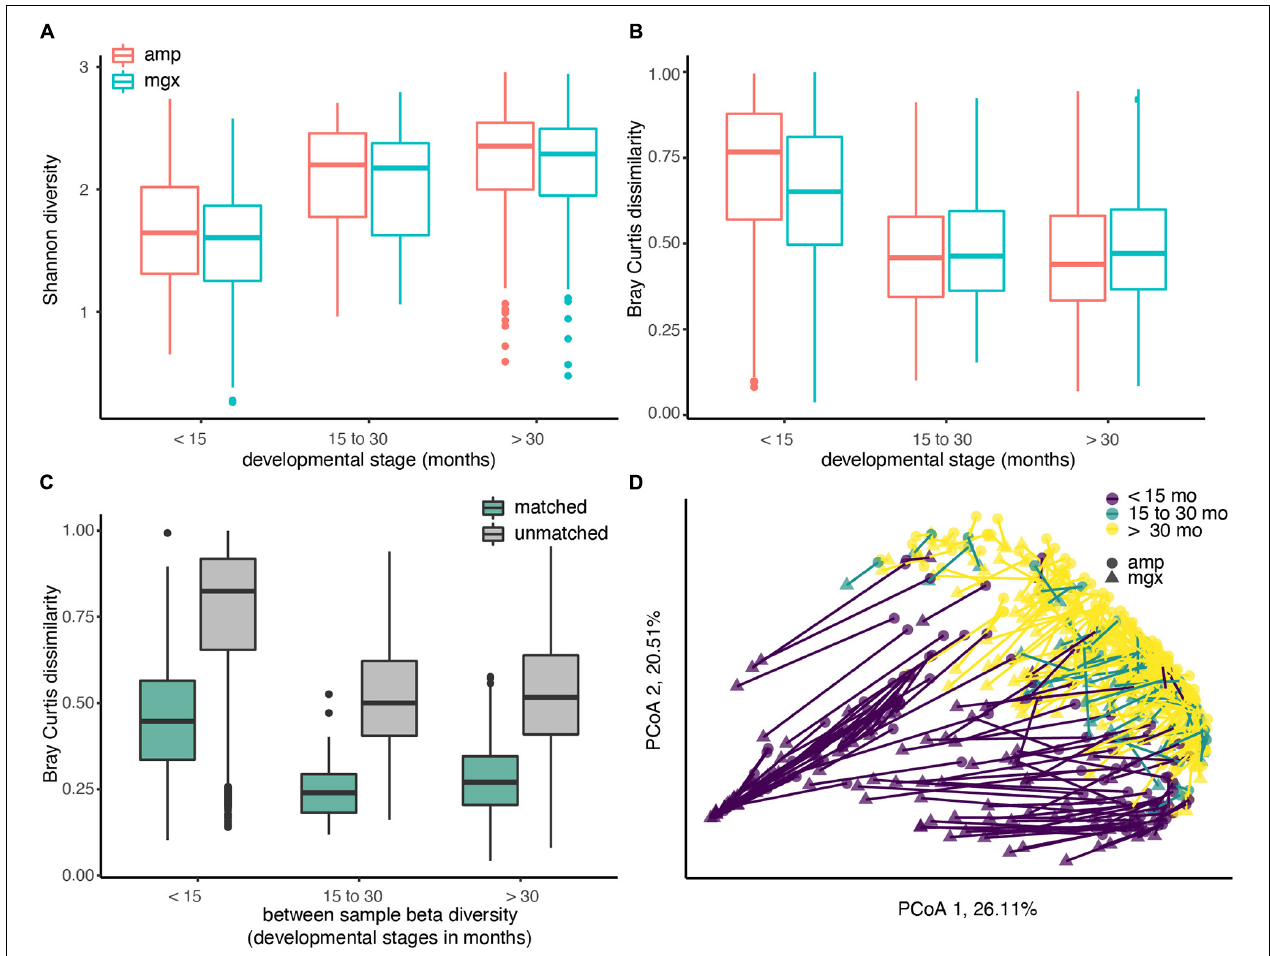
FIGURE 1 | Diversity of the child gut microbiome differs by age, regardless of profiling method. Microbiome communities from 338 children were sequenced using 16S rRNA (abbreviated “amp”) and shotgun metagenomic (abbreviated “mgx”) profiling. (A) Alpha diversity was calculated using the Shannon diversity index for each child. Boxplots are grouped by age and colored by profiling method. (B) Beta-diversity was quantified using pair-wise Bray-Curtis dissimilarities between all children within the same profiling method and developmental stage. (C) Bray-Curtis dissimilarities between 16S and metagenomic profiles for matched samples (from same fecal sample), 16S and metagenomic profiles among unmatched samples (from different fecal samples). (D) Beta-diversity was visualized using Principal Coordinate analysis (PCoA). The first two principal coordinate axes, which together explain 46.62% of variation, are shown. Each dot represents one taxonomic profile, with lines connecting profiles from the same sample. Colors represent developmental stages and shape represent profiling